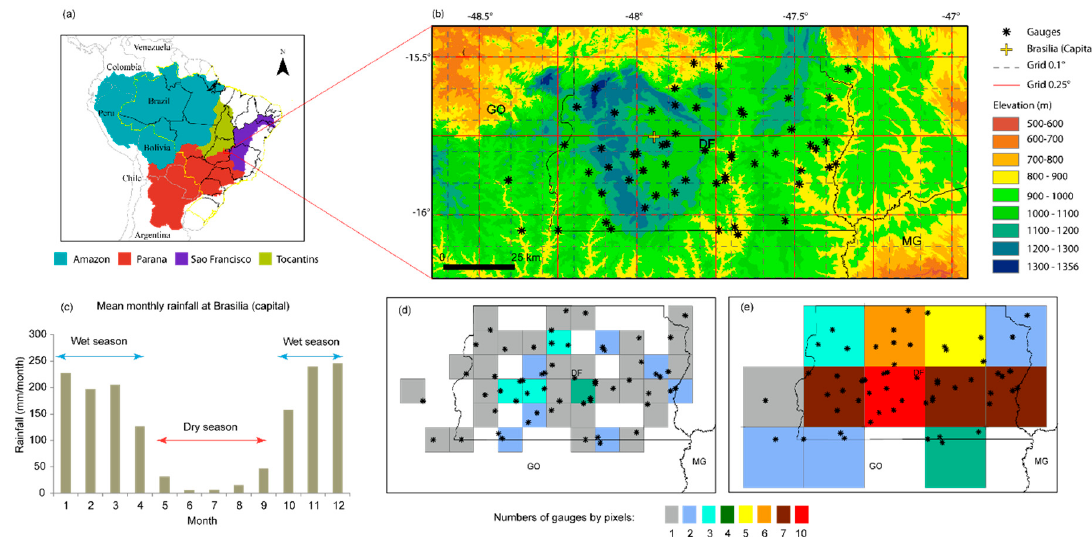
Figure 1. Study area: location within four important hydrographic regions ( a ); rain gauges and elevation map ( b ); average monthly precipitation between 1963 and 2016 for Brasilia’s rain gauge ( c ); number of gauges by grid-cell for the 0.1° grid ( d ); and number of gauges by grid-cell for the 0.25° grid ( e ).